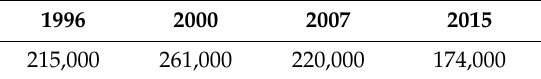
Table 5. YABs at Seoul Archdiocese (aged